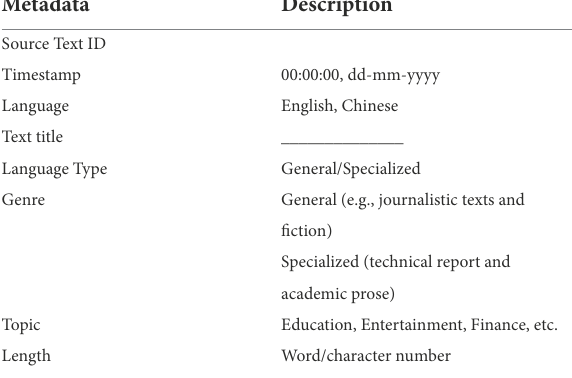
TABLE 2 Metadata for the translation